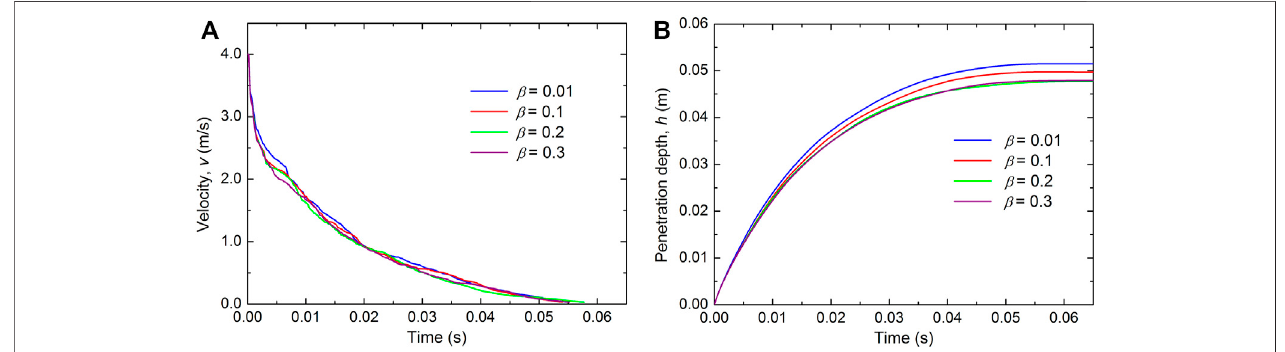
FIGURE13| Evolutionsof (A) velocityand (B) penetrationdepthofprojectilesforthenumericaltestsofvariousdampingratios(undertheconditionof v 0 =4.0 m/s).